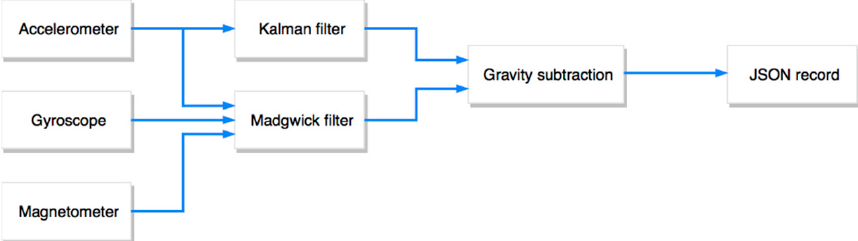
Figure 5. The data fusion algorithm.